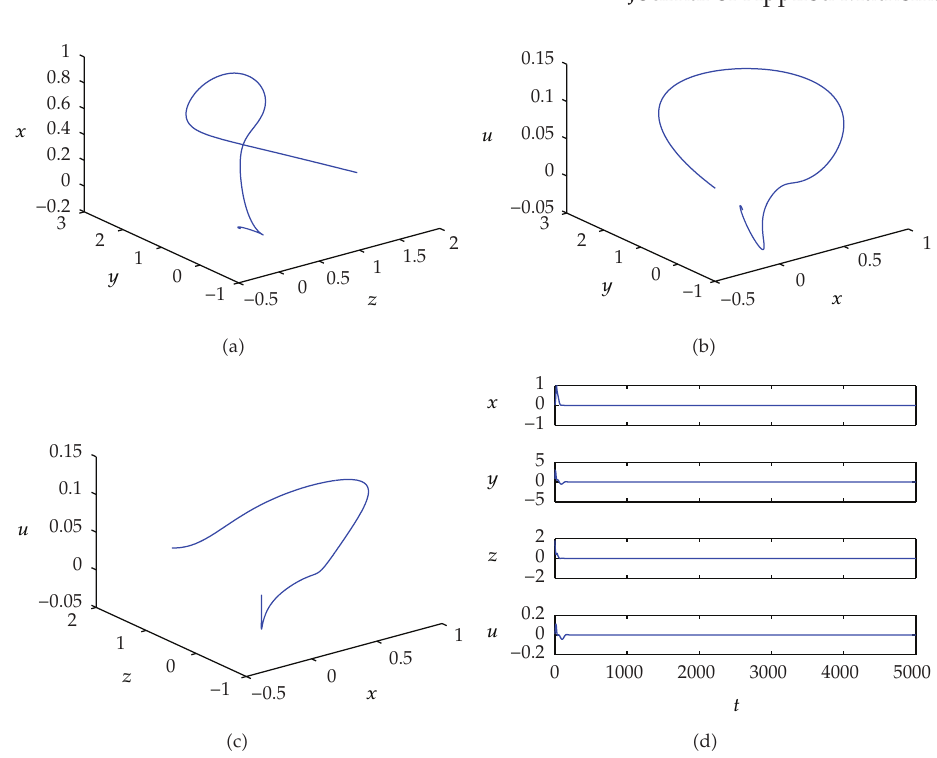
Figure 4: The stable equilibrium point O (cid:6) 0 , 0 , 0 , 0 (cid:7) of the controlled system (cid:6) 4.1 (cid:7)